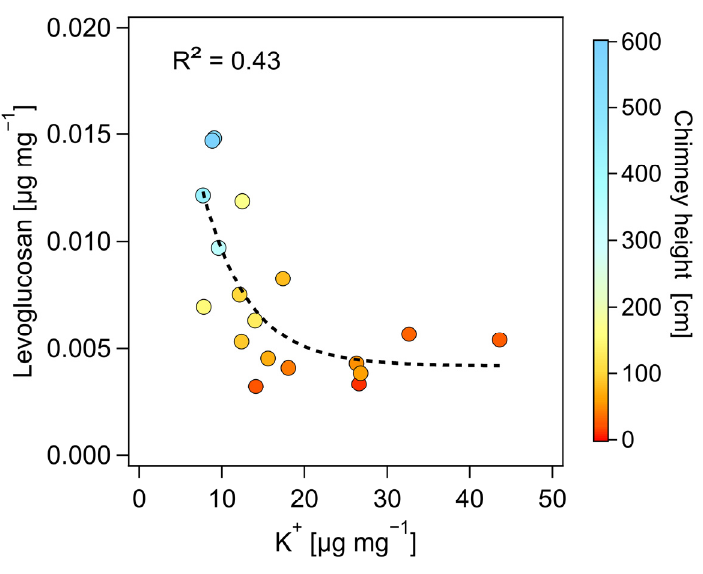
Figure 5. Relationship between levoglucosan and K + in the chimney deposit samples. The color scale reflects the height of deposit sample in chimney.